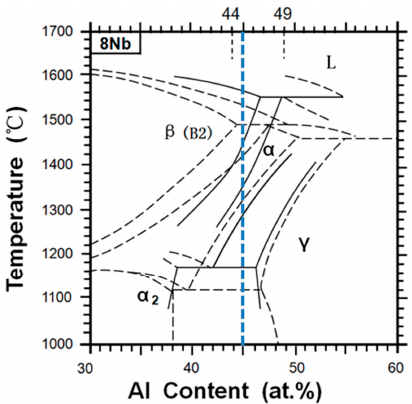
Figure 8. Phase diagram of Ti-45Al-8Nb. Adapted from ref. [22], with permission from Elsevier, 2009.